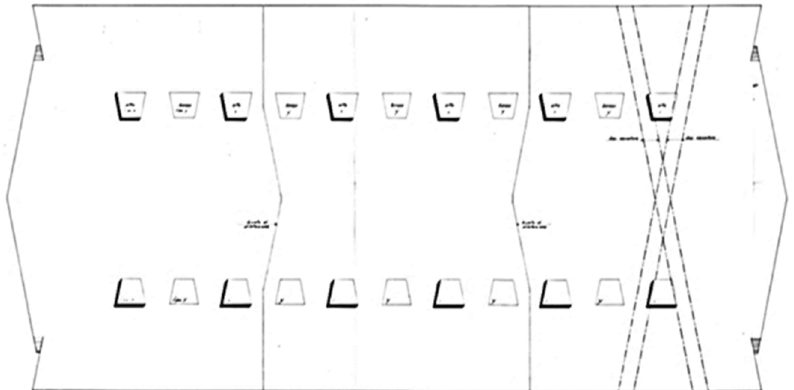
Figure 8. Scheme of the plan of Morandi’s Pavilion V showing the division into three blocks linked by joints.